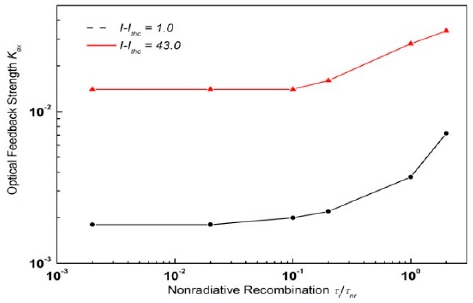
Figure 4. Variations of the strength of the optical feedback K ex , at HB point with the ratio τ r / τ nr at two values of current ( II thc ) = 1.0, and 43.0 mA.